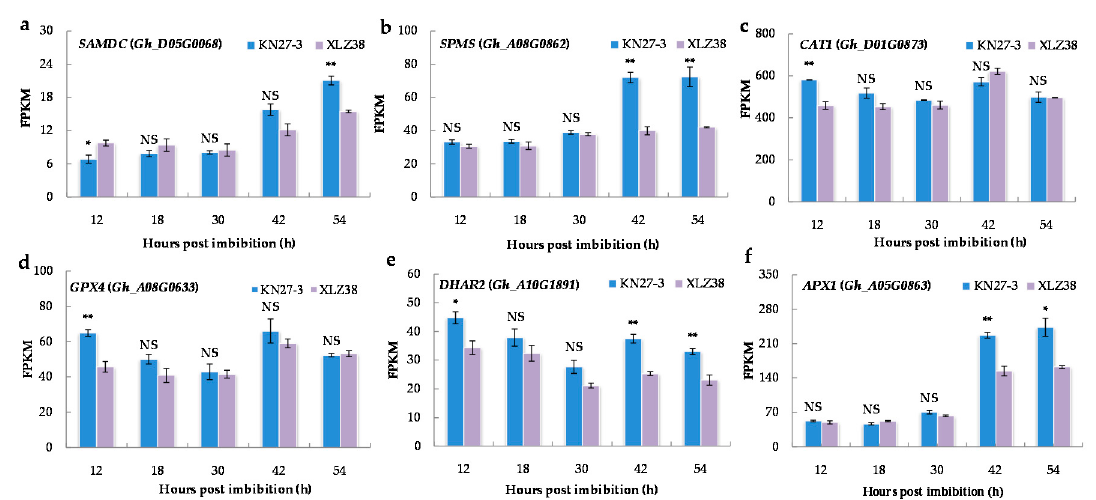
Figure 6. The expression of DEGs related to spermine and polyamine biosynthetic process and antioxidant activity. ( a ) SAMDC , ( b ) SPMS , ( c ) CAT1 , ( d ) GPX4 , ( e ) DHAR2 , ( f ) APX1 . The Y axis shows the FPKM means of three independent replicates ± SE. Bars marked with asterisks indicate di ff erences change between the same hour (* p < 0.05, ** p < 0.01) according to Duncan’s multiple range test using SPSS software. “NS” represents no di ff